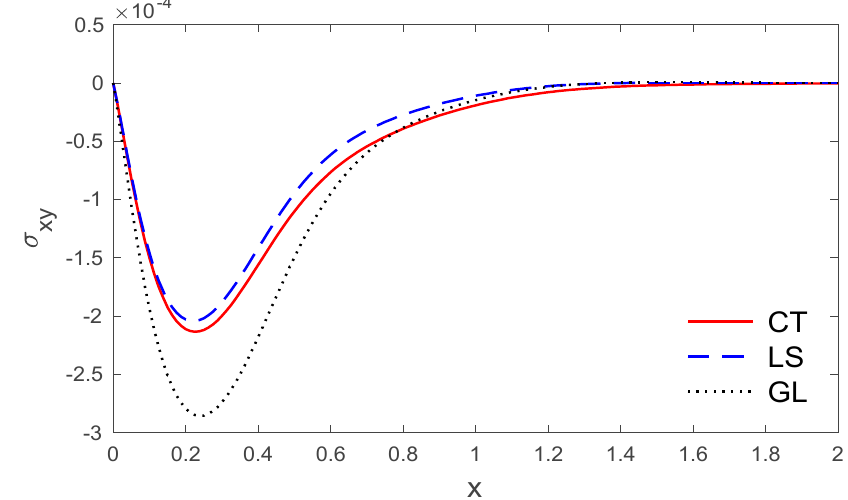
Figure 9. The stress variations 𝜎 (cid:3051)(cid:3051) via 𝑥 with, y = 0.5 under the three models.